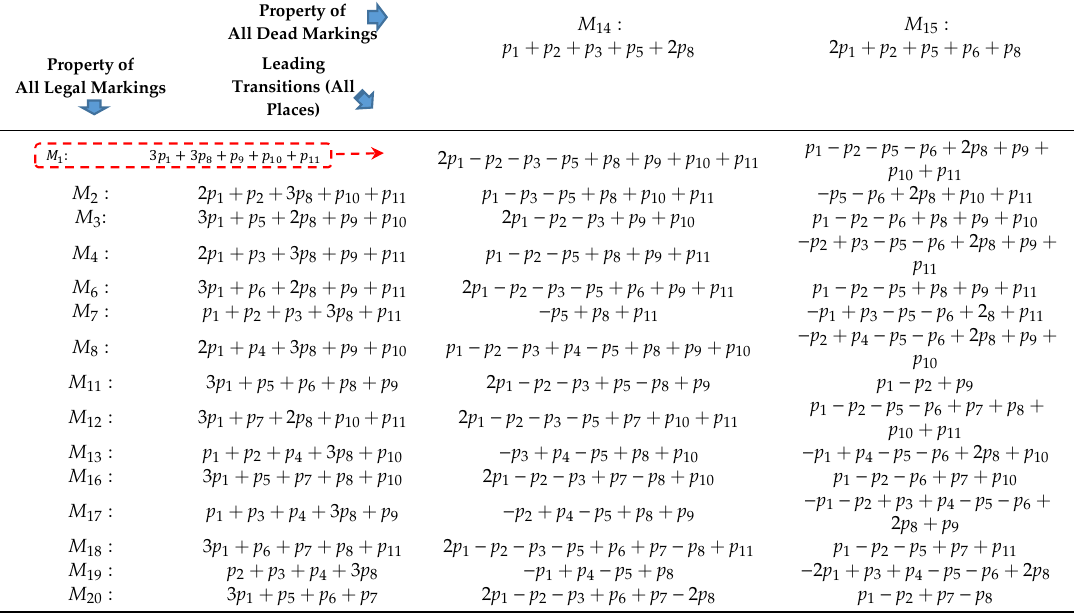
Table 3. Simplified GCAM (SGCAM) of Example 1.